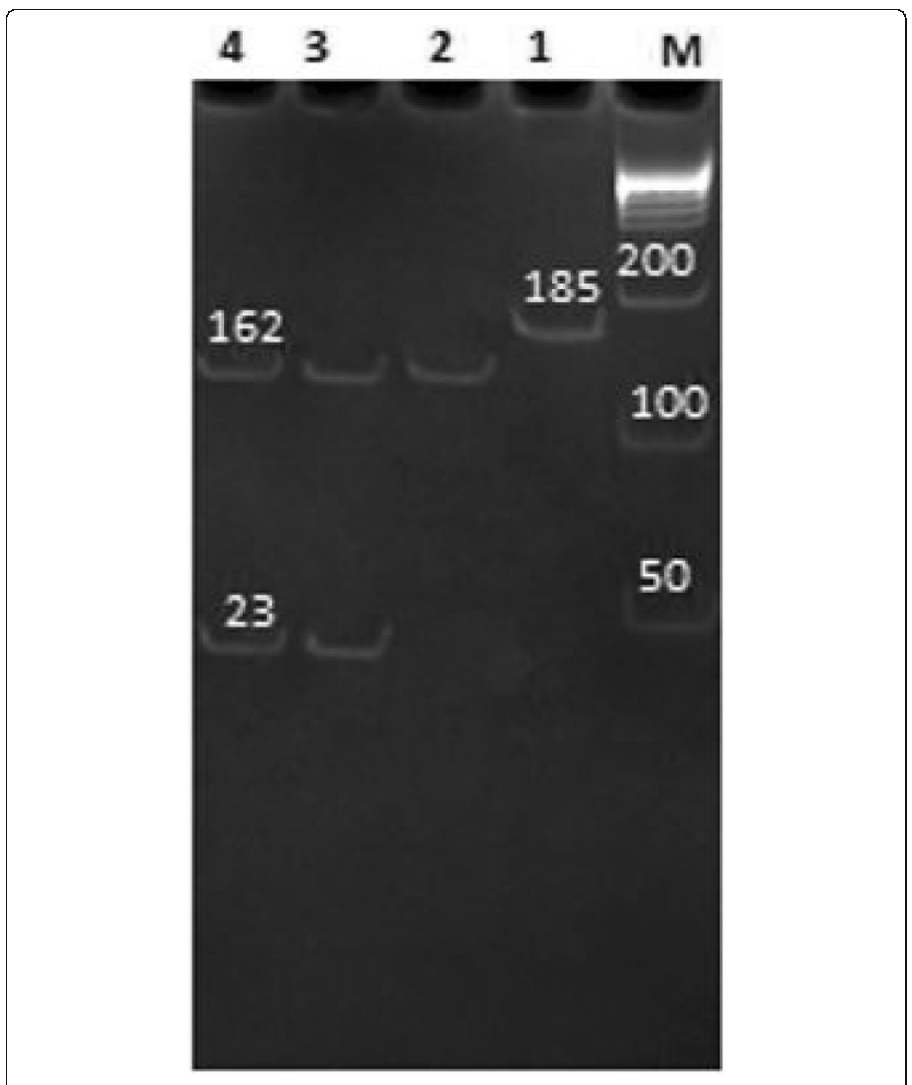
Fig. 1 RFLP detection of Pro12Ala polymorphism of PPAR γ 2 gene using gel electrophoresis. M: Ladder 50